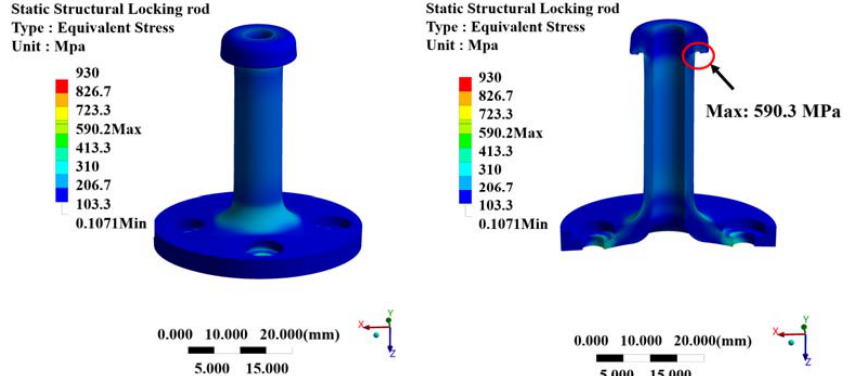
Figure 5. Boundary conditions and mesh for strength checks of core parts of the locking module. ( a ) Boundary conditions of locking rod and locking claw; ( b ) Figure 6 Grid of locking rod and locking claw.